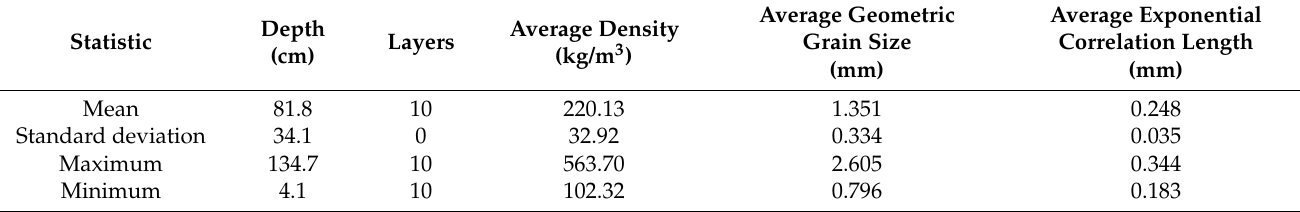
Figure 5. SNTHERM-simulated snow parameter profiles centered at 92.375°E: ( a ) geometric grain size (D max ); and ( b ) snow density. Table 2. Statistics of multiple-layer snow properties of global samples in 5°–85° N and 90°–95° E grids.